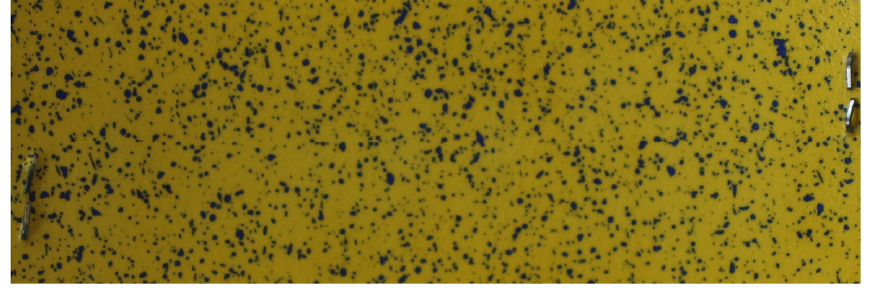
Figure 6. Reference card.